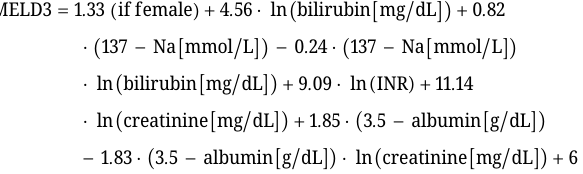
Figure 1: Flowchart showing inclusion and exclusion of